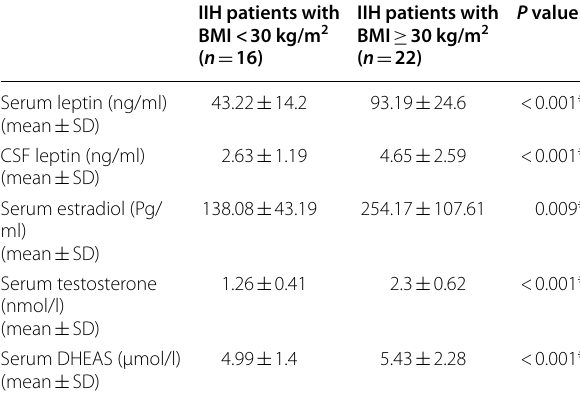
CSF : cerebrospinal fluid, DHEAS : dehydroepiandrosterone sulfate, IIH idiopathic intracranial hypertension, *: